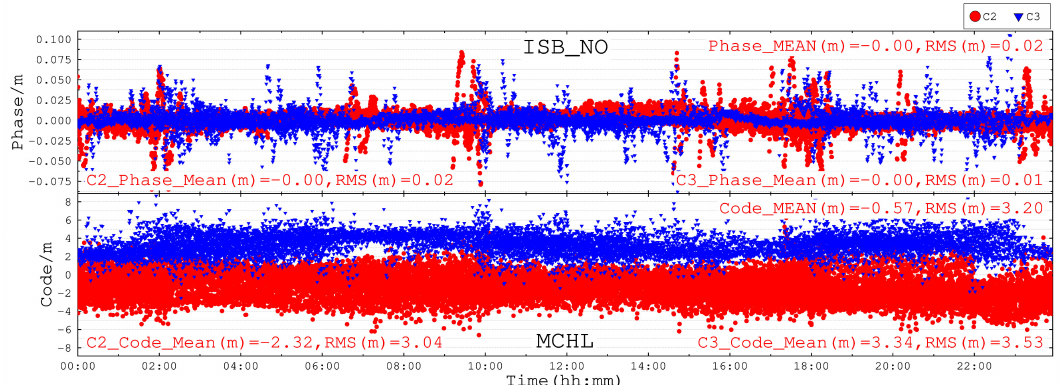
Figure 22. The residuals of BDS-2 and BDS-3 code and carrier-phase observations with the ISB_NO scheme at station MCHL, DOY 097,